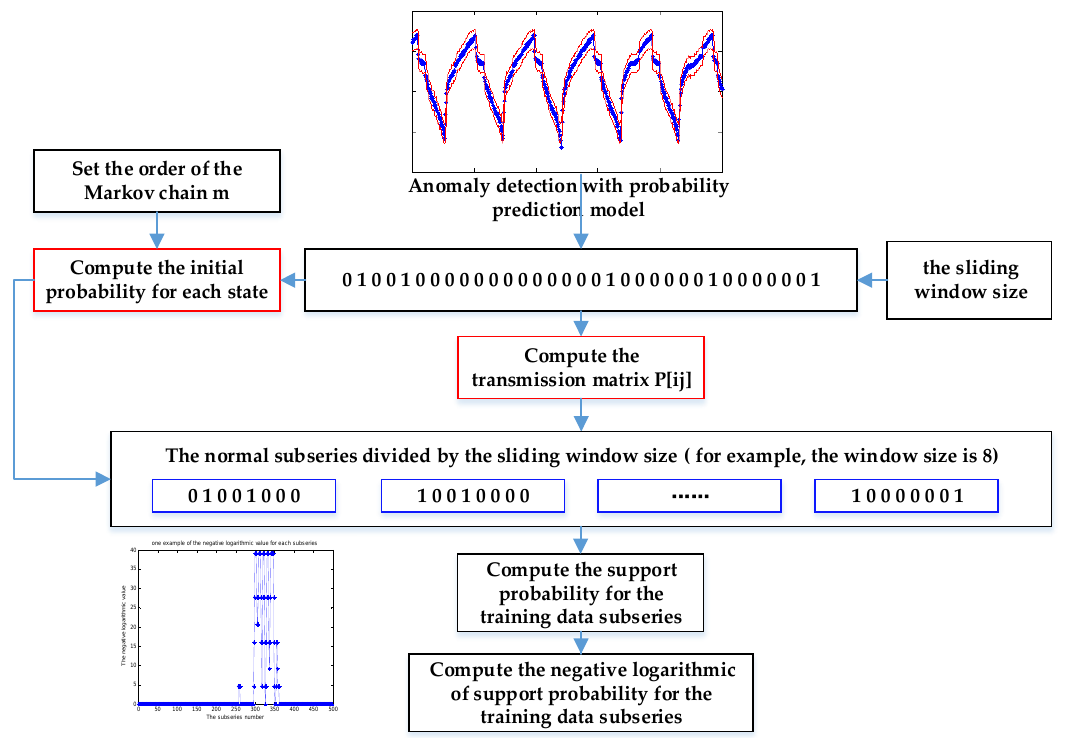
Figure 3. Markov chain training for normal available data.